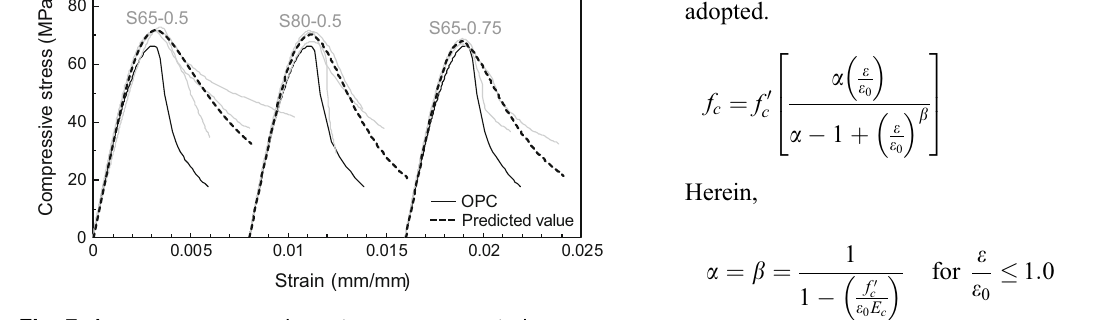
Fig. 7 Average compressive stress versus strain curves (after 28 days).